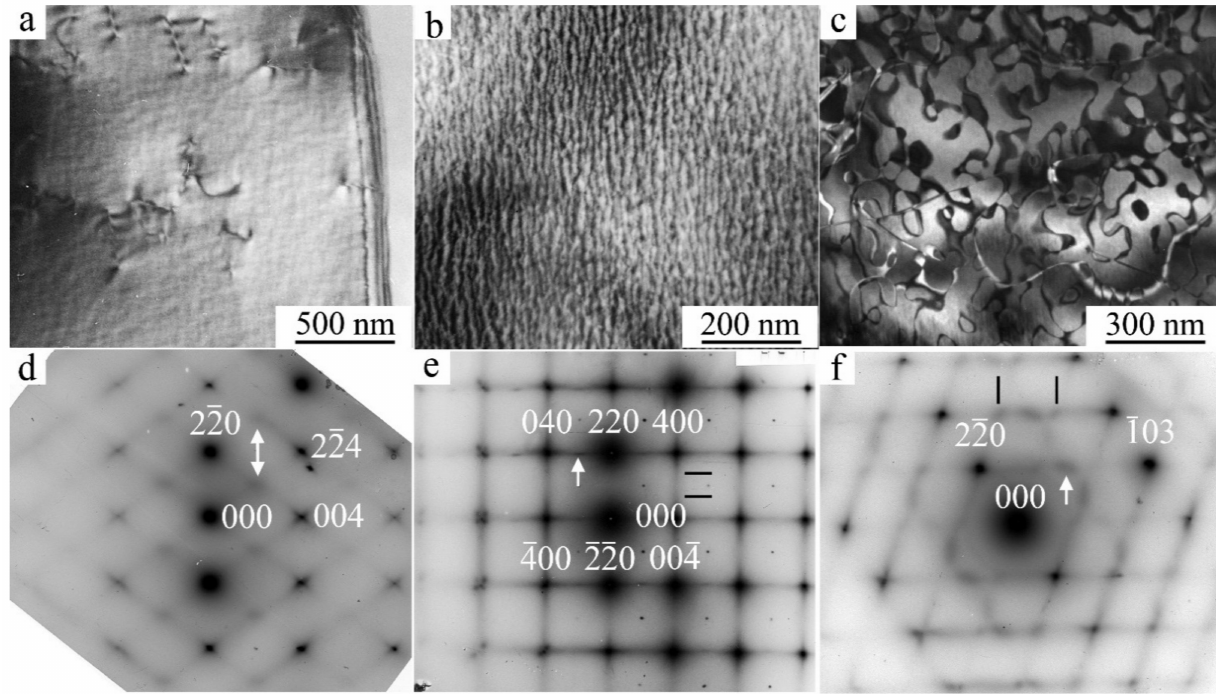
Figure 2. ( a – c ) Dark-field TEM images of ( a , b ) tweed contrast, ( c ) anti-phase boundaries, in the β 1 -austenite of the quenched alloy Cu–14Al–3Ni and ( d – f ) corresponding SAED patterns, with zone axis ( d ) [110], ( e ) [001], and ( f ) [331]; D0 3 . Observations at ( a , d ) 450 K, and ( b , c , e , f